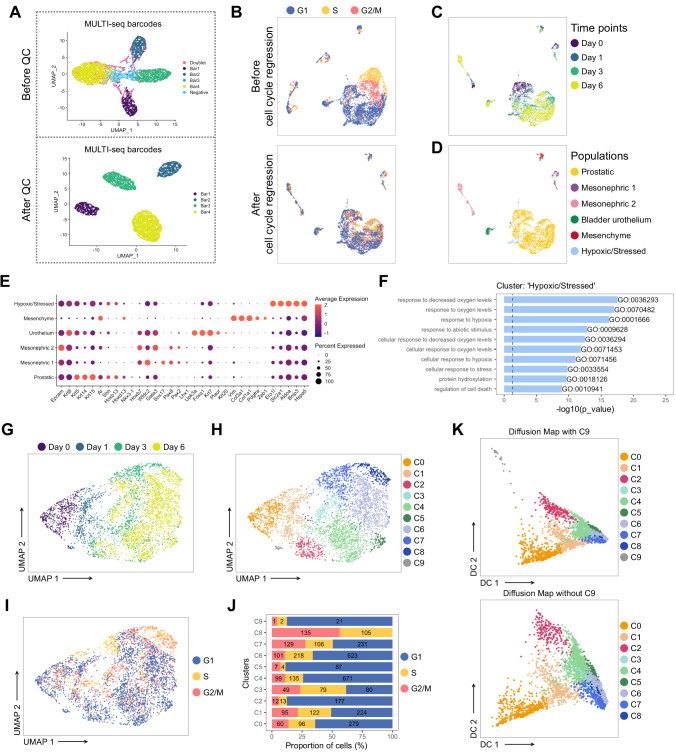
Pre-processing of the scRNA-seq dataset of UGS explant cultures.(A) UMAP visualization in MULTI-seq barcodes space before (top) and after (bottom) quality control and barcode filtration (see Materials and methods for details). (B) UMAP visualization of the dataset colored by estimated cell cycle phase (top). Due to the strong underlying impact on clustering, the cell cycle effect was regressed out (bottom). (C, D) UMAP visualization of the dataset colored in C by experimental time point and in D by labeled populations. (E) Dot plot showing the expression of selected marker genes associated with each labeled population. (F) Bar plots of the 10 most significantly (g:Profiler adjusted p-value<0.05) enriched gene ontology (GO) terms (GO:BP, Biological Processes) on the differentially upregulated genes specific to the ‘Hypoxic/Stressed’ cluster. (G–I) UMAP visualization of the prostatic subset (from D), labeled by time points in G, clusters in H, estimated cell cycle phase in I. (J) Percentage of cells in the different estimated cell cycle phases in each clusters. (K) Diffusion maps representation of the prostatic subset using the first two diffusion components with (top) and without C9 (bottom). C9 was excluded for downstream analyses due to its outlying profile.